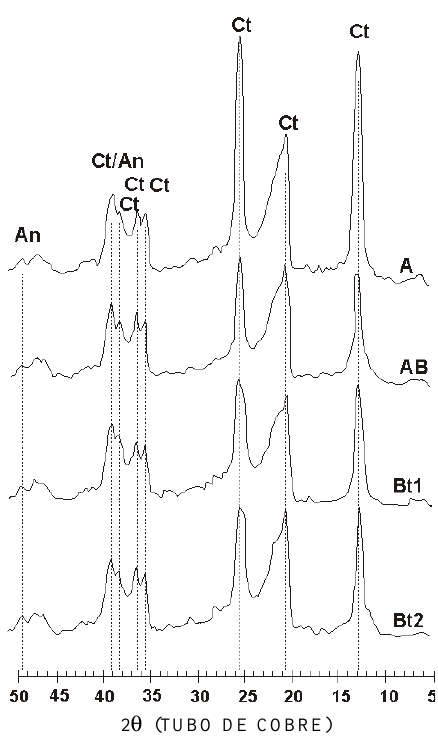
2 θ (TUBO DE Figura 7. Difratogramas de raios-X da fração argila desferrificada do Argissolo Amarelo distrófico típico - PAd3 (lâminas em pó). Ct - caulinita; Ct/ An- caulinita/anatásio e An - anatásio.